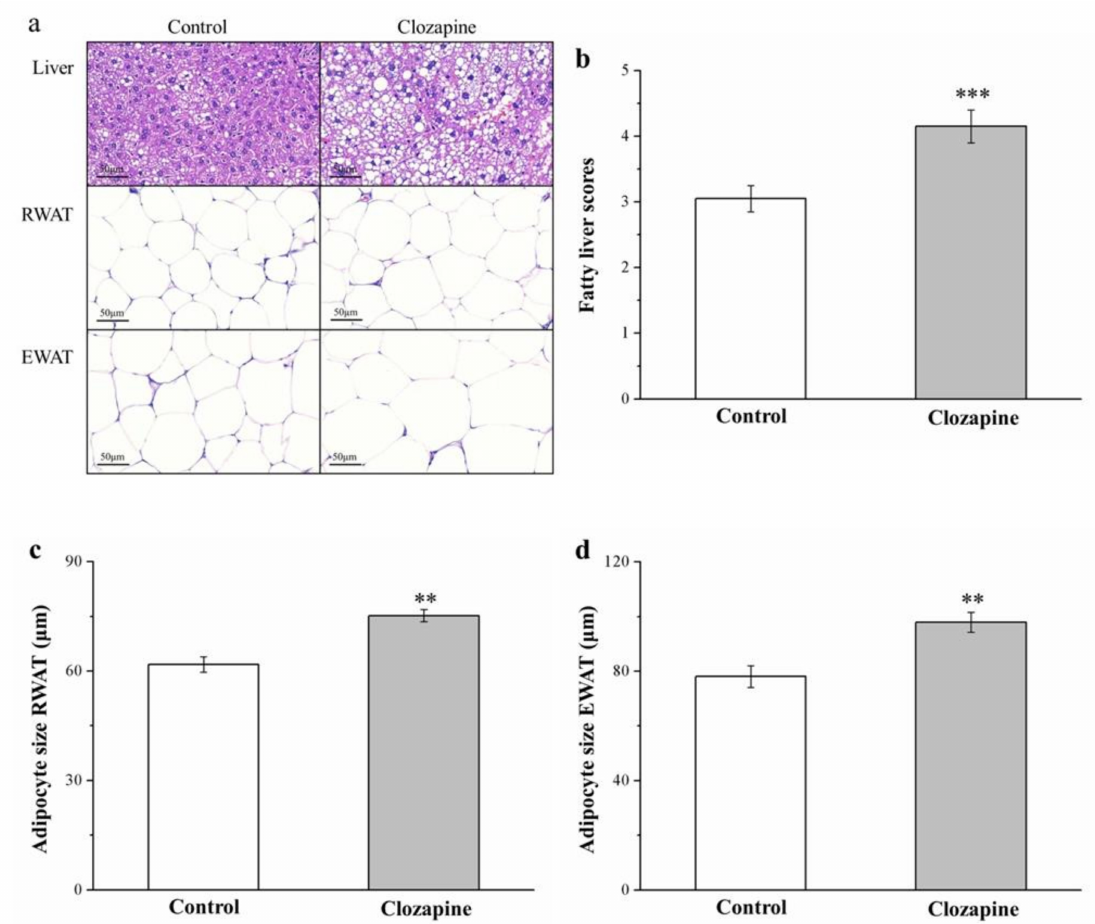
Figure 3. ( a ) Hematoxylin and eosin (H&E)-stained sections of liver, EWAT, and RWAT tissues (magnification, 200 × ); ( b ) fatty liver score; and size of ( c ) RWAT and ( d ) EWAT adipocytes for clozapine (receiving 2 mg/kg/day) and control groups. Data are mean ± standard deviation ( n = 10). ** p < 0.01, *** p <